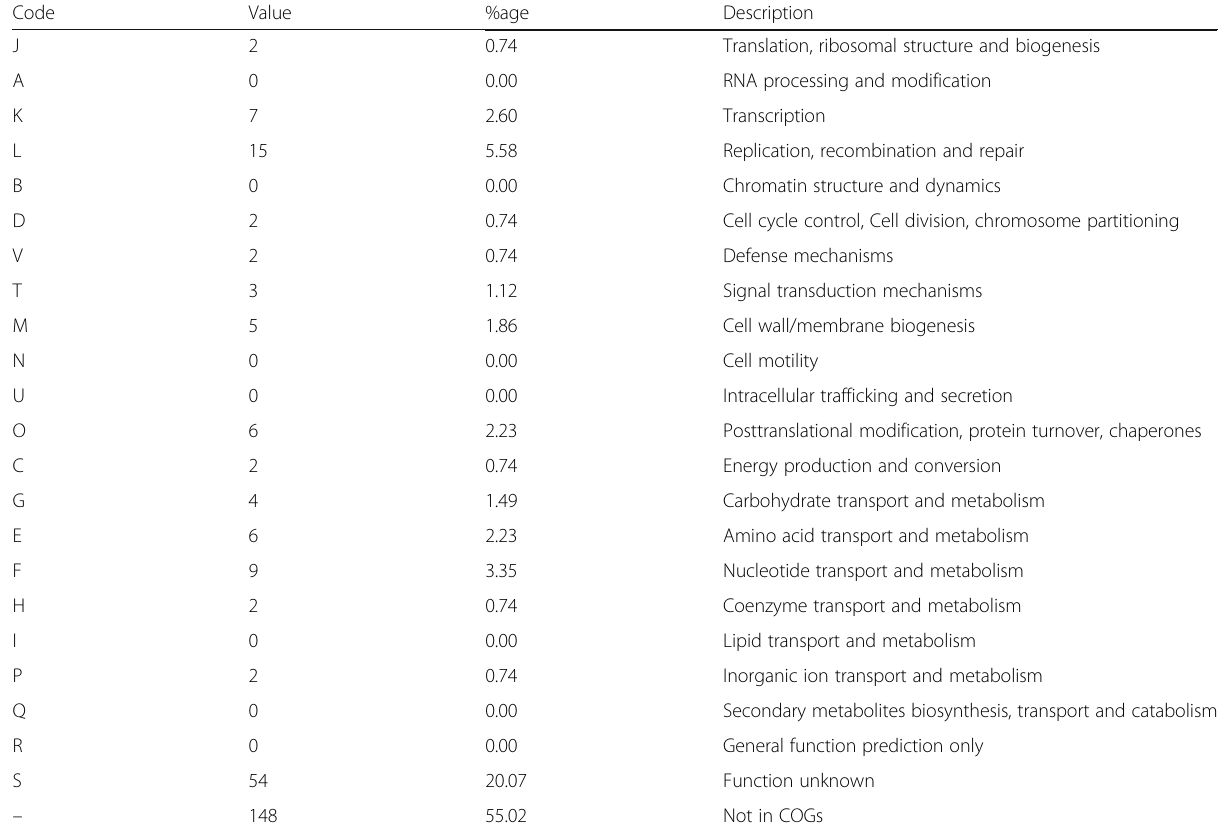
Table 4 Number of genes associated with general COG functional